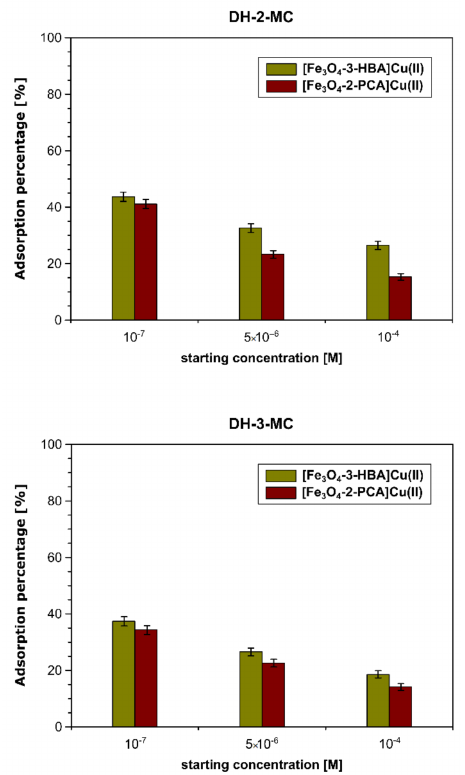
Figure 10. The percentages of the chalcones adsorbed on the hybrid materials complexed with Cu(II) ions for: ( top ) DH-2-MC and ( bottom ) DH-3-MC, investigated using ESI-MS